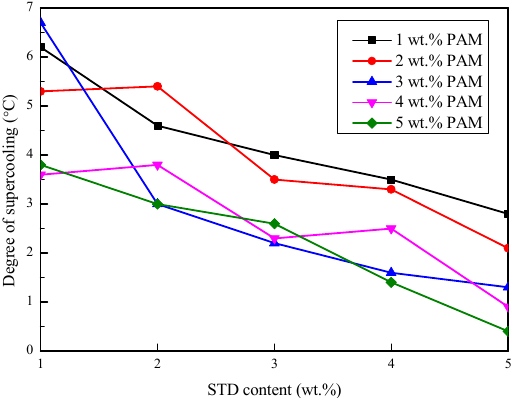
Figure 9. Effect of PAM and STD content on the degree of supercooling of the Na 2 SO 4 ·10H 2 O composites.